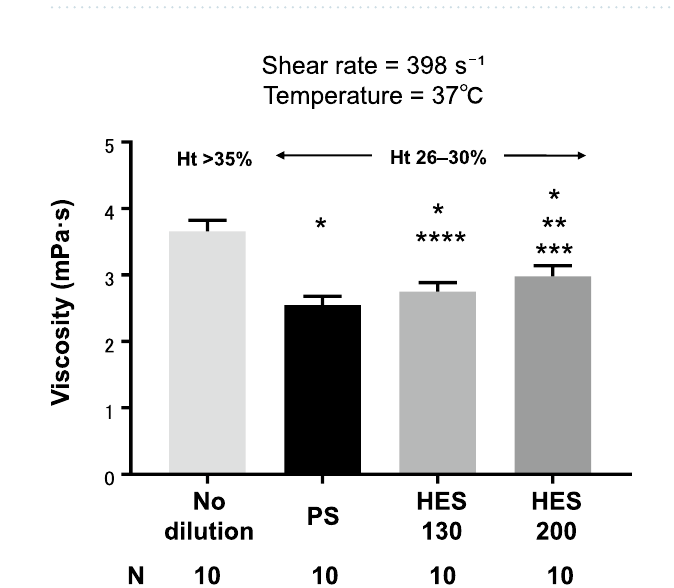
Figure 5. Quantification of coagulation factors by ELISA. ELISA enzyme-linked immunosorbent assay, VWF von Willebrand factor, FV coagulation factor V, FVIII coagulation factor VIII. *P = 0.003 vs no-dilution, **P = 0.001 vs PS, § P = 0.03 vs no-dilution, † P < 0.0001 vs no-dilution, †† P = 0.004 vs no-dilution, ††† P < 0.0001 vs HES200, †††† P = 0.0002 vs HES200.